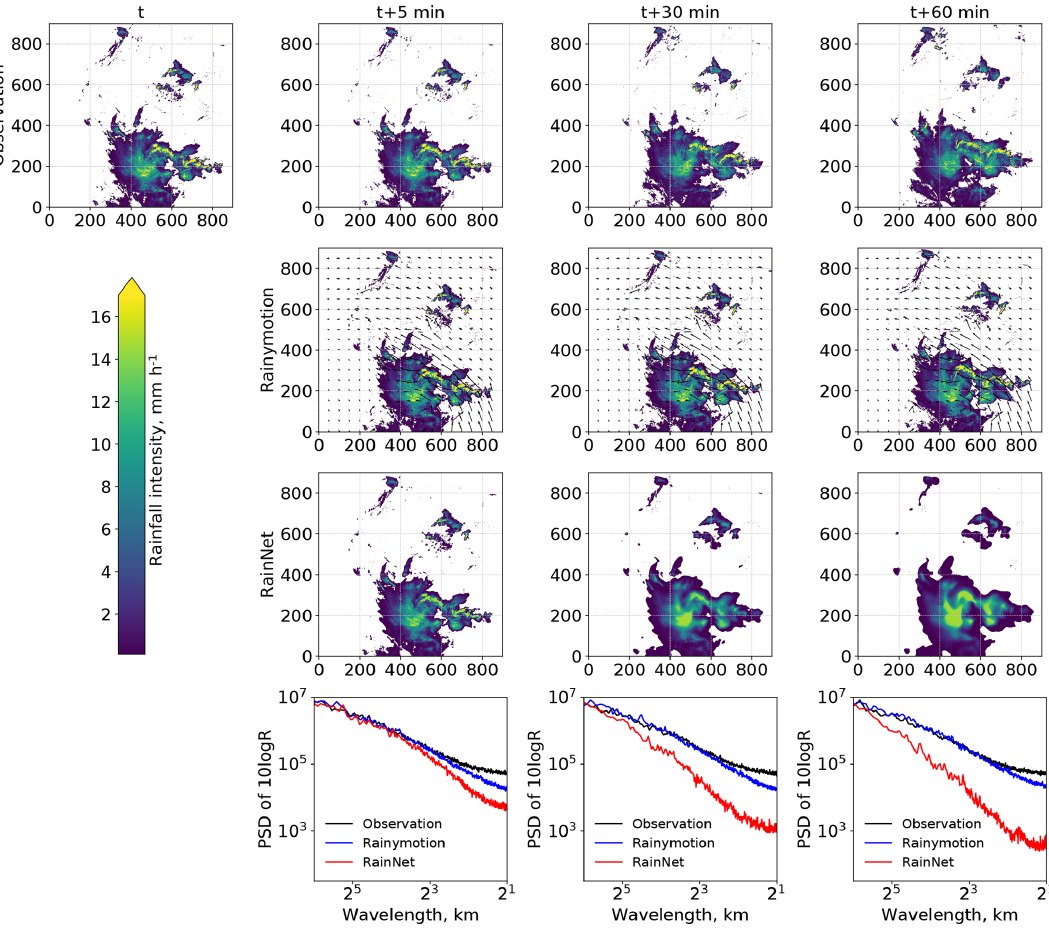
Figure 4. Precipitation observations as well as Rainymotion and RainNet nowcasts at t = 29 May 2016, 19:15UTC. Top row: observed precipitation intensity at time t , t + 5, t + 30, and t + 60min. Second row: corresponding Rainymotion predictions, together with the underlying velocity field obtained from optical flow. Bottom row: power spectral density plots for observations and nowcasts at lead times of 5, 30, and 60min.